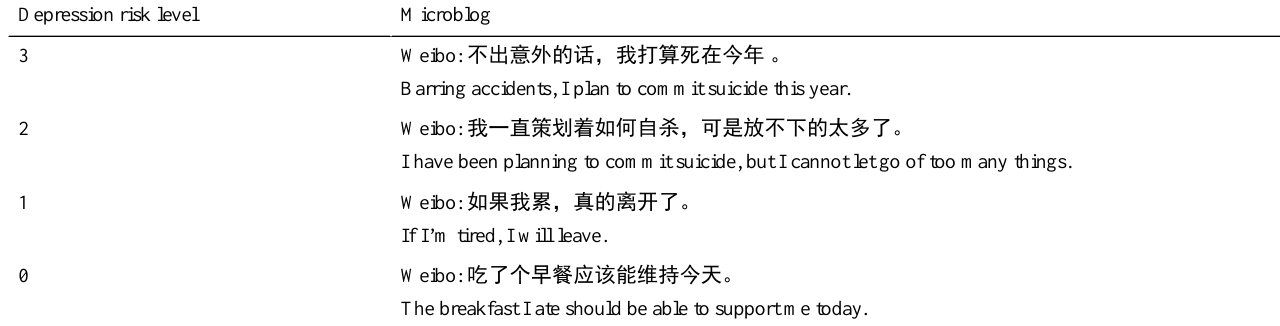
Table 1. Examples of different depression risk levels in the dataset. MicroblogDepression risk level